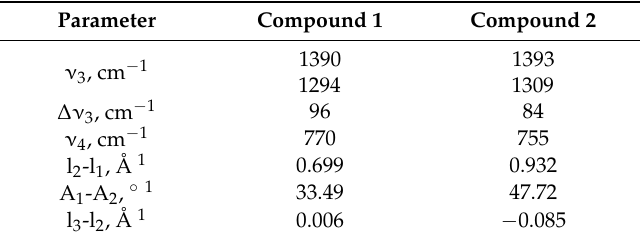
Table 1. Bands of nitrate asymmetric stretching ( ν 3 ) and in-plane bending ( ν 4 ) vibrations and geometric coordination mode criteria.